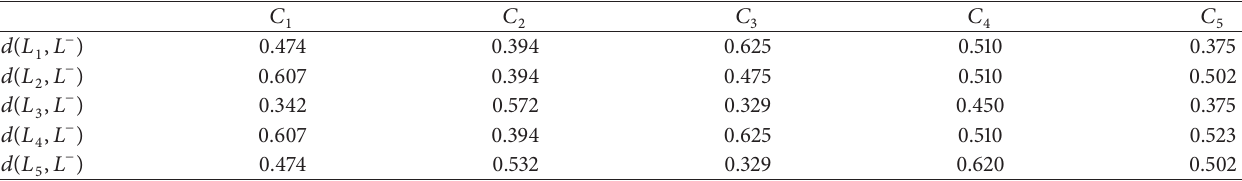
Table 9: Distance with negative-ideal solution with respect to each criterion.